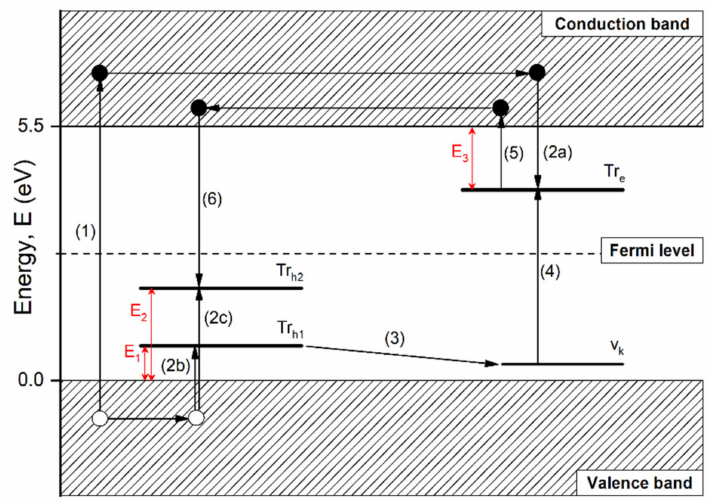
Figure 10. A simplified model of thermoluminescence observed in double-doped LiMgPO 4 :Tb,Tm crystals. The arrows indicate consecutive processes involved in the TL phenomenon. These are as follows: (1) the creation of free charge carriers by ionizing radiation, (2) the trapping of charge carriers by Tm-related electron trapping sites (2a), the Tb-related hole trapping sites (2b, 2c), (3) the hole release and creation of a V k -center, (4) the recombination of a V k center with the electron trapped in Tr e , (5) electron release to the conduction band, (6) recombination of the electron with the hole trapped in the Tb-related trapping